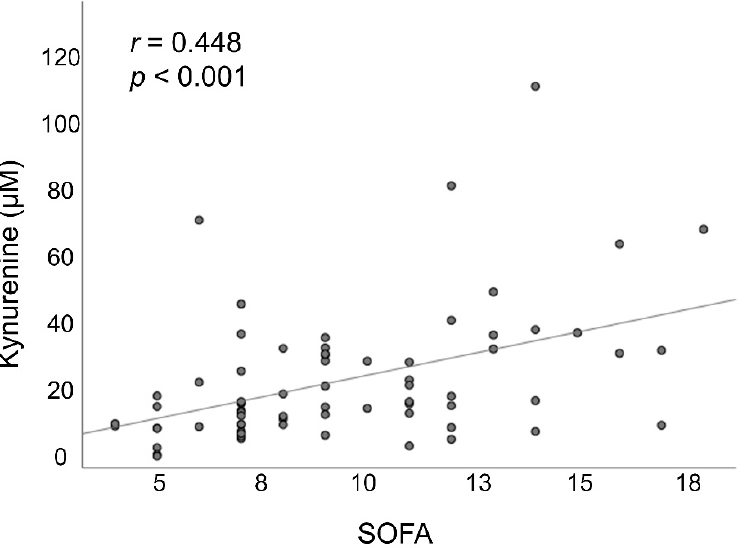
Figure 3. The association between plasma kynurenine levels and SOFA scores at day 1 after ARDS onset. ARDS: acute respiratory distress syndrome; SOFA: sequential organ failure assessment.